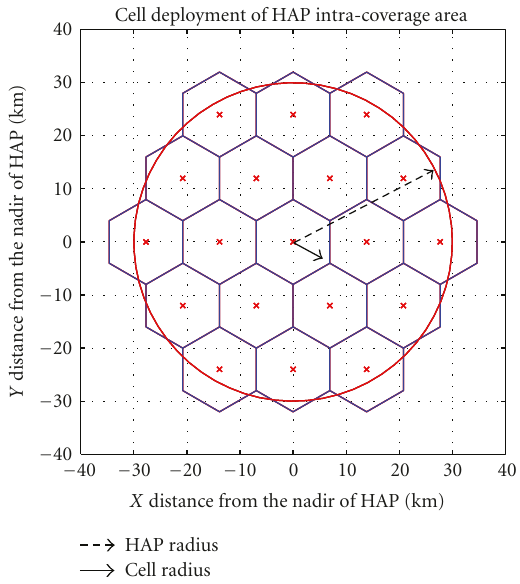
Figure 2: Plane view of cell deployment of HAP coverage